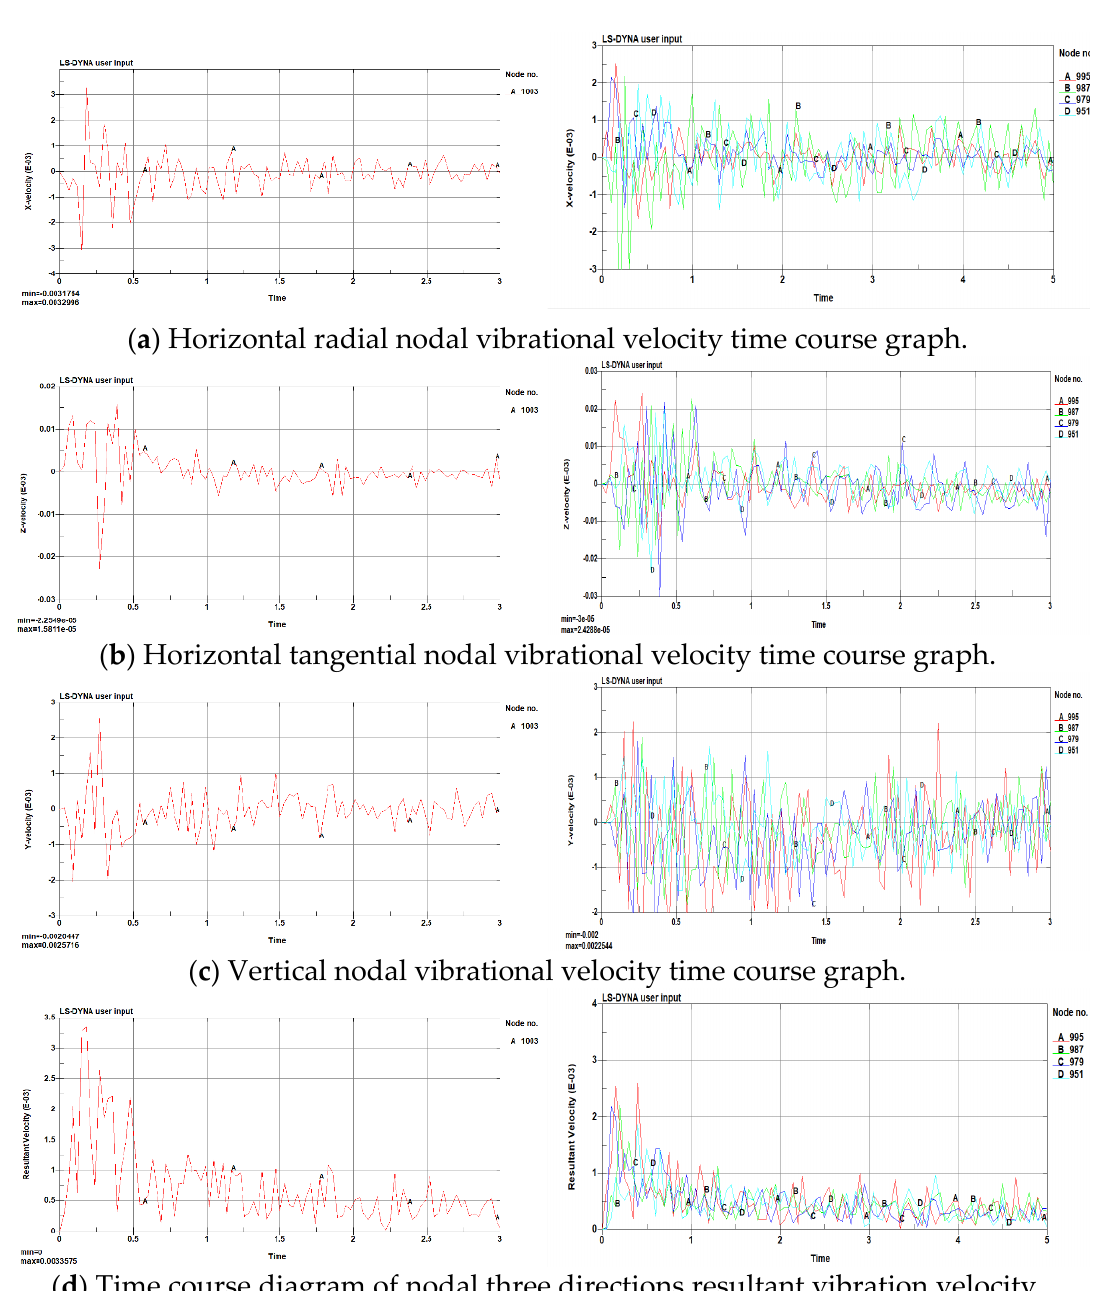
Figure 10. Time course diagram of nodal vibrations at different horizontal distances for an elevation of 20 m.